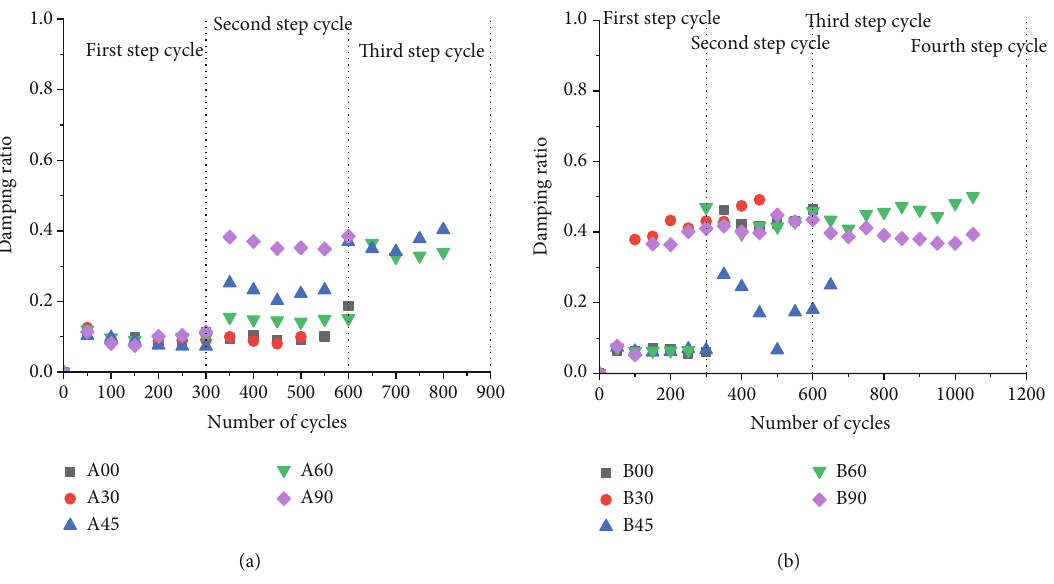
Figure 14: Damping ratio curves for groups A and